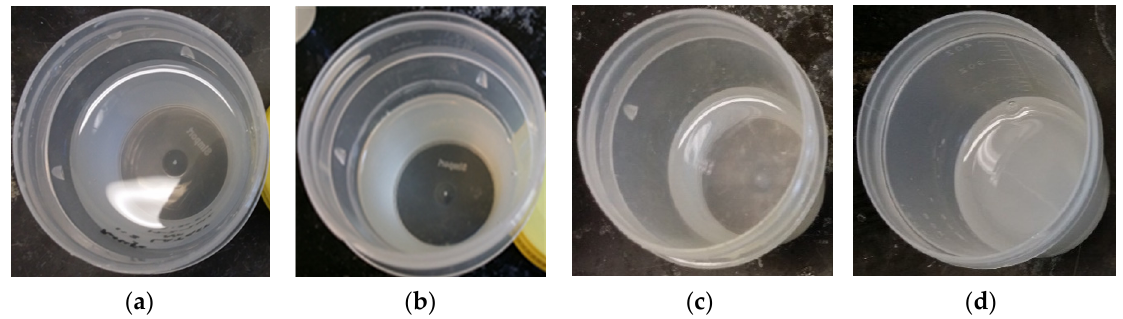
Figure 7. Pot-life of precursor solutions ( a ) TG and ( b ) LA(TG) after 30 days of preparation. ( c ) ST after 30 h of preparation and ( d ) LA(ST) after 17 h of preparation.